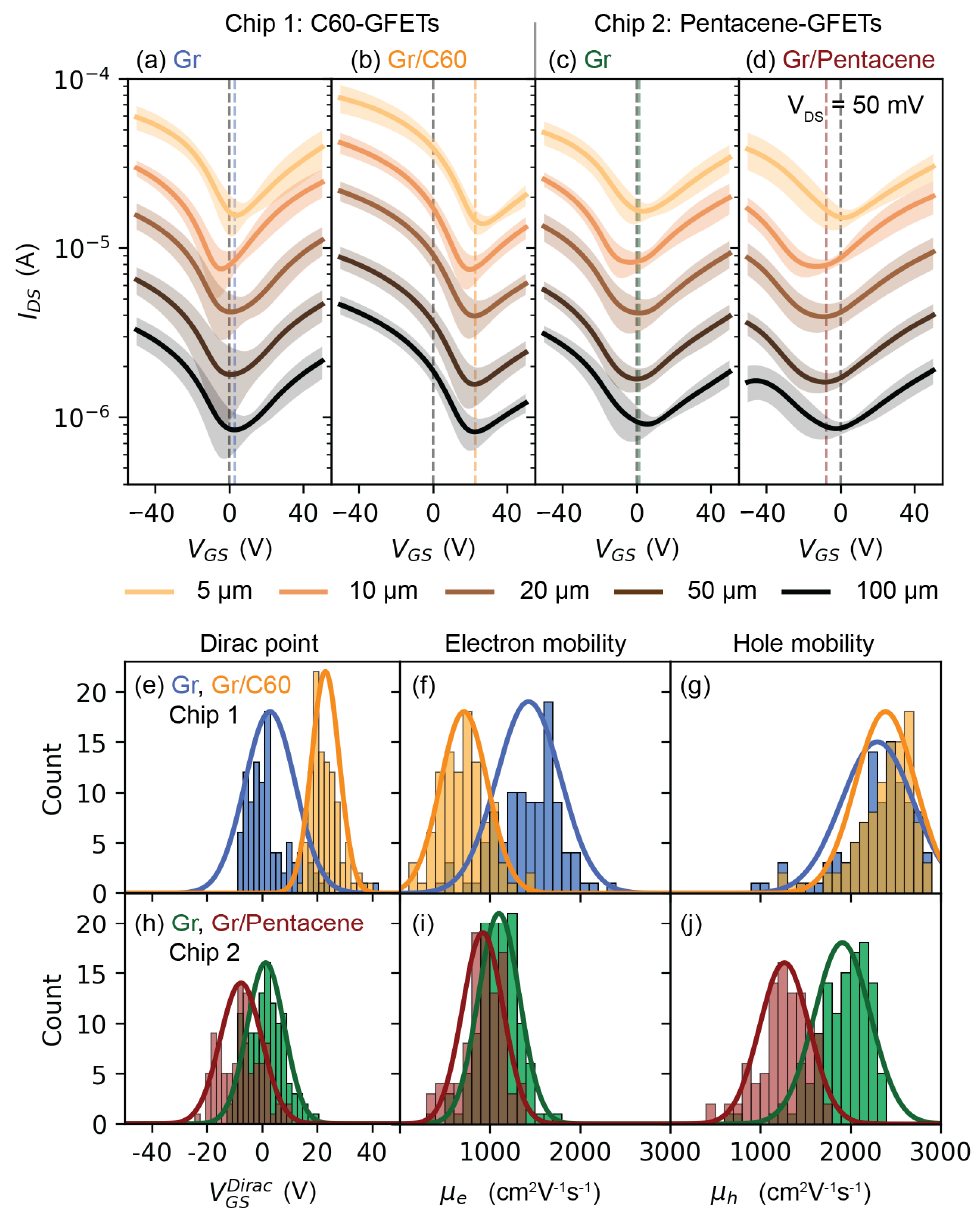
Figure 3. GFETs’ electrical measurements. ( a ) Average transfer characteristic ( I DS vs. V GS ) of pristine CVD graphene FETs before C60 deposition (Chip 1, 101 devices, all L included). The shaded areas are the standard deviations. ( b ) Average transfer characteristic of the C60-GFETs (Chip 1, 101 devices, all L included). ( c ) Average transfer characteristic of pristine CVD graphene before Pentacene deposition (Chip 2, 119 devices, all L included). ( d ) Average transfer characteristic of the Pentacene-GFETs (Chip 2, 98 devices, all L included). ( e ) Histograms of the graphene Dirac position ( V Dirac ) GS before (blue) and after deposition of C60 (orange). ( f ) Histograms of the graphene electron mobility ( µ e ) before (blue) and after deposition of C60 (orange), all L included. ( g ) Histograms of the graphene hole mobility ( µ h ) before (blue) and after deposition of C60 (orange), all L included. ( h ) Histograms of the graphene Dirac position ( V Dirac ) before (green) and after deposition of Pentacene (red), all L GS included. ( i ) Histograms of the graphene electron mobility ( µ e ) before (green) and after deposition of Pentacene (red), all L included. ( j ) Histograms of the graphene hole mobility ( µ h ) before (green) and after deposition of Pentacene (red), all L included. Bins width of graphene Dirac point position and mobility histograms are 2 V and 100 cm 2 V − 1 s − 1 ,